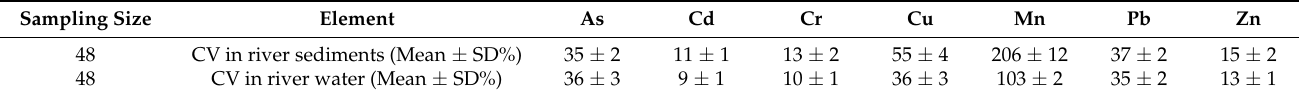
Table 2. Coefficient of variation and standard deviation (CV ± SD % ) of potentially toxic elements (PTEs) in Danshui River. Sampling Size